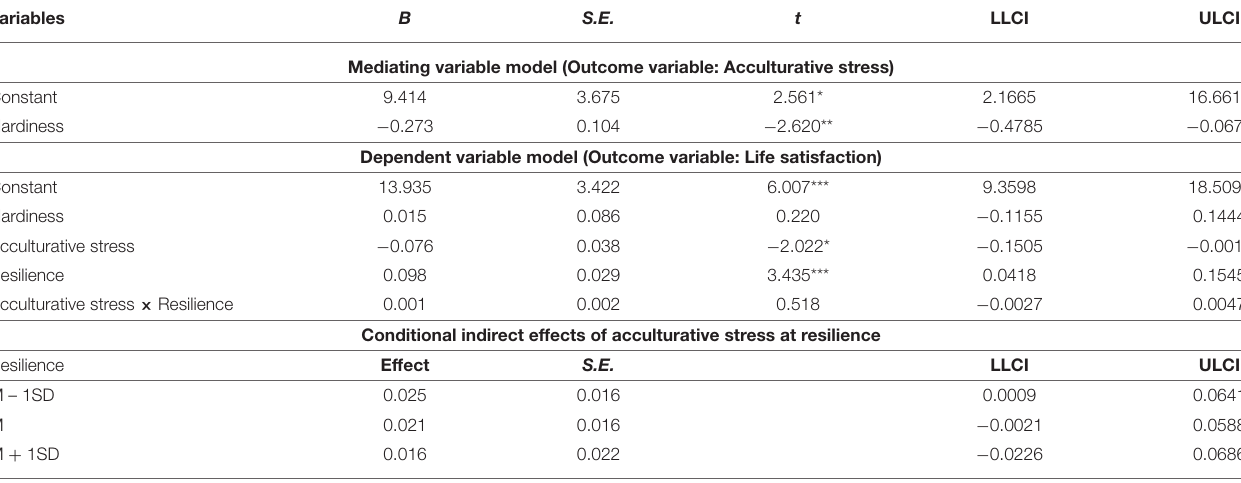
TABLE 3 | Moderating effect and moderated the mediating effect of resilience through acculturative stress on hardiness and life satisfaction.